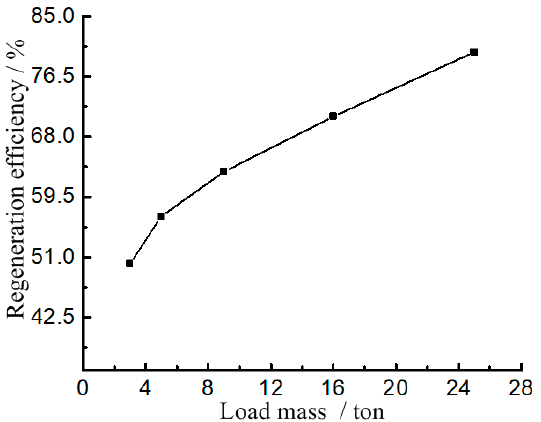
ffi ciency under a di ff erent load mass. Figure 18. Regeneration efficiency under a different load mass. Figure 18. Regeneration e